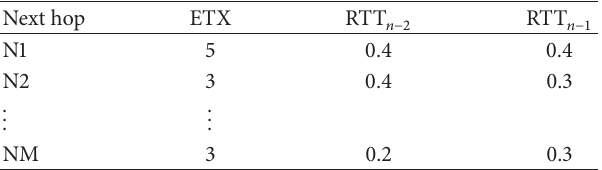
Table 2: Parameter setting records in